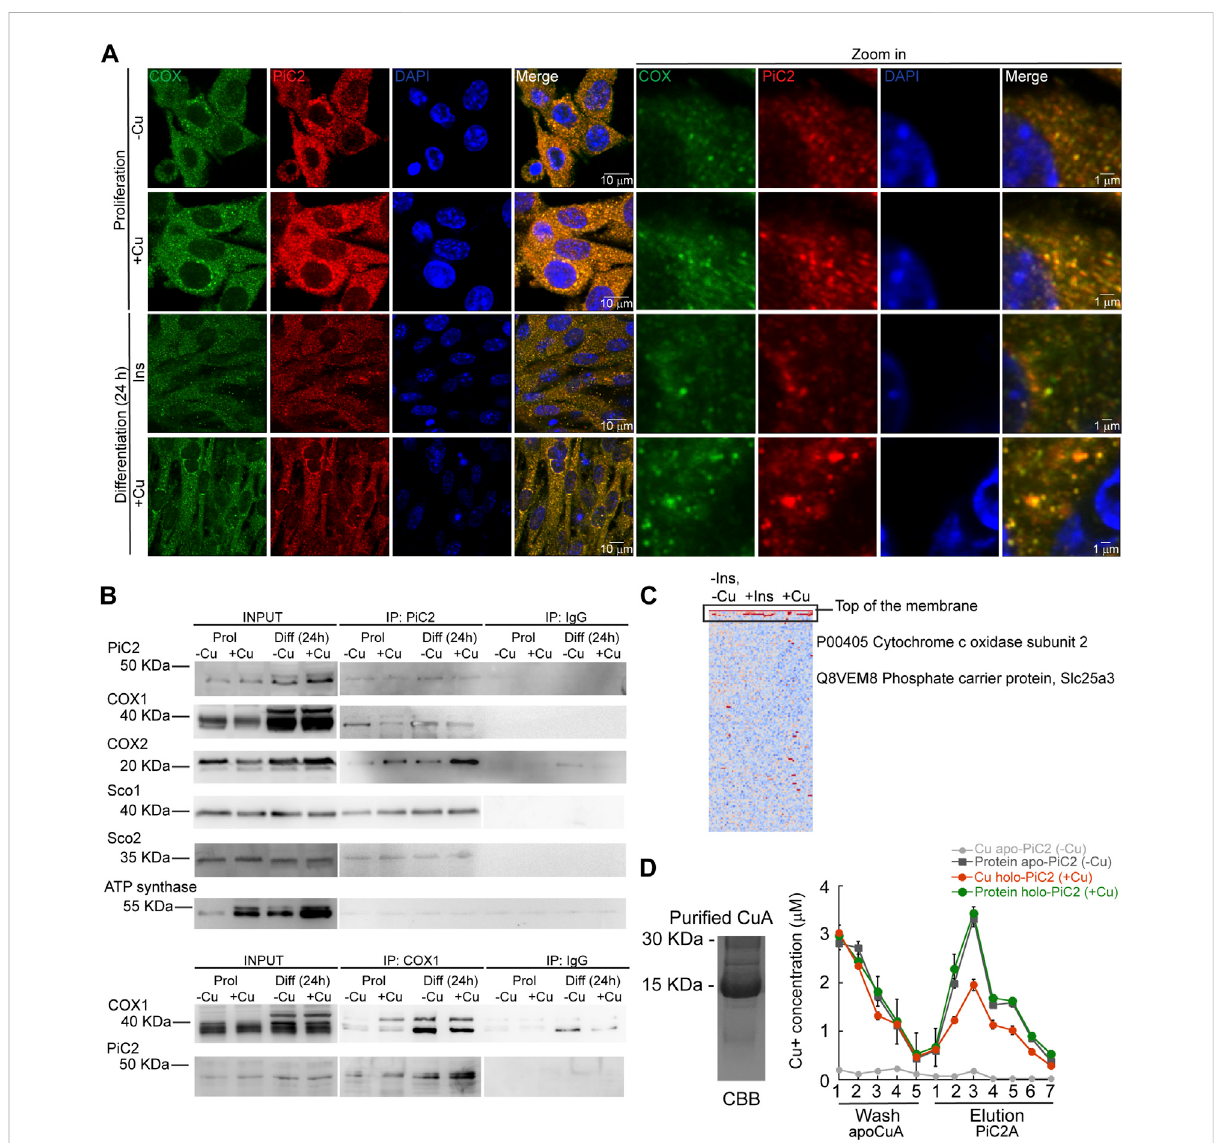
FIGURE 4 mPiC2 interactswith cytochrome coxidase and other mitochondrial cuproproteins inprimary myoblasts derived from mouse satellite cells. (A) mPiC2 co-localizes with COX. Confocal imaging showing mPiC2 (red) and COX (green) co-localization (yellow). The nucleus is stained with DAPI (blue). Set of four panels on the right are zooms of areas in the set of four panels on the left. (B) Co-IP of mPiC2 with mitochondrial cuproproteins. Proliferating and differentiating primary myoblasts were treated with or without Cu. Co-IP was performed with and anti-PiC2 antibody and probed against PiC2 and COX1, COX2, Sco1, and Sco2; the ATP synthase was used as a negative control. Reciprocal co-IP using an anti-COX1 antibodywasprobedwithananti-COX1andanti-PiC2antibodies. (C) SynchrotronbasedX-Ray fl uorescenceanalysescoupletoproteinsequencing bymassspectrometryofnativePAGEgelsfromwholecellextractsofdifferentiatingprimarymyoblasts showedthepresenceofmPiC2andCOXina highmolecularbandthatcontainedcopper(indicatedbyblackbox). (D) Cu + transferfrommetallatedPiC2Atoapo-CuA.Cu + concentrationisshown inred,andthecorrespondingproteinisshowningreen.ControlCu + transferexperimentisshowninpale(Cu + signal)anddarkgray(proteinsignal).In all cases, the contents of the wash and elution fractions are shown. The data presented in this fi gure corresponds to three independent biological replicates shown as the mean for Cu + and protein concentration